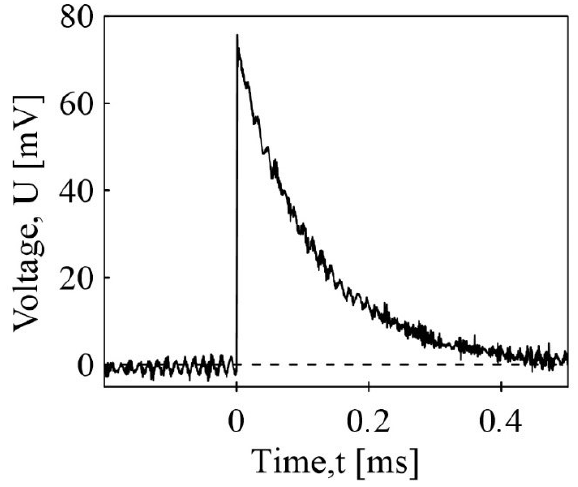
Figure 6. The electrospun PVDF membrane time dependent response to its mechanical deformation. The inner electro–mechanical coupling induced output voltage (~77 mV peak) from the membrane mechanical response to the input DC signal.